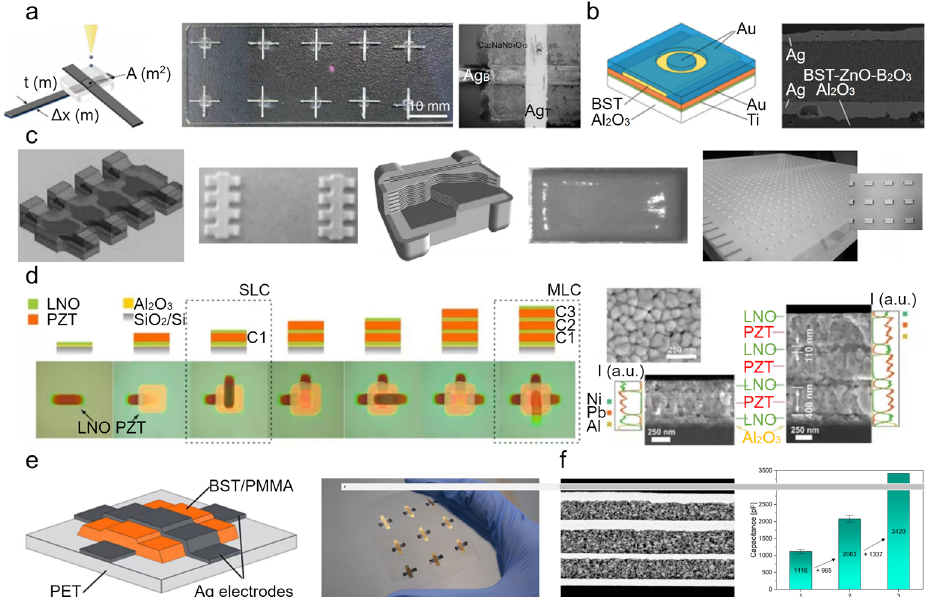
Figure 9. Multi-material 3D-printed ceramic capacitors. ( a ) Schematic illustration of the design concept of the Ag/Ca 2 NaNb 4 O 13 /Ag capacitor ( left ) and photograph of ten fully inkjet-printed Ag/Ca 2 NaNb 4 O 13 /Ag capacitors on a glass substrate ( middle ) and two overlapped Ag electrodes separated by the printed Ca 2 NaNb 4 O 13 layer ( right ) [184]. ( b ) Schematic illustration of the design concept for the Ag/Ba 0.6 Sr 0.4 TiO 3 -ZnO-B 2 O 3 /Ag varactor ( left ), and SEM image of the fully inkjet- printed Ag/Ba 0.6 Sr 0.4 TiO 3 -ZnO-B 2 O 3 /Ag varactor ( right ) [185]. ( c ) Photographs of fabricated 784 MLCCs with 15 internal electrodes and, consequently, 14 dielectric layers using a multi-material 3D inkjet printer [186]. ( d ) Photograph of sequentially inkjet-printed LNO and PZT layers to form MLCC components ( left ), and SEM image of the fully inkjet-printed MLCC components on SiO 2 substrate ( right ) [187]. ( e ) Schematic illustration of the design concept for the Ag/Ba 0.6 Sr 0.4 TiO 3 /PMMA/Ag capacitor ( left ) and a photograph of the fully inkjet-printed flexible capacitor array on PET substrate ( right ) [202]. ( f ) SEM image of the fully inkjet-printed MLCC component with three dielectric layers on a PET substrate ( left ) and increasing capacitances of the MLCC component with every additional layer ( right ) [205].